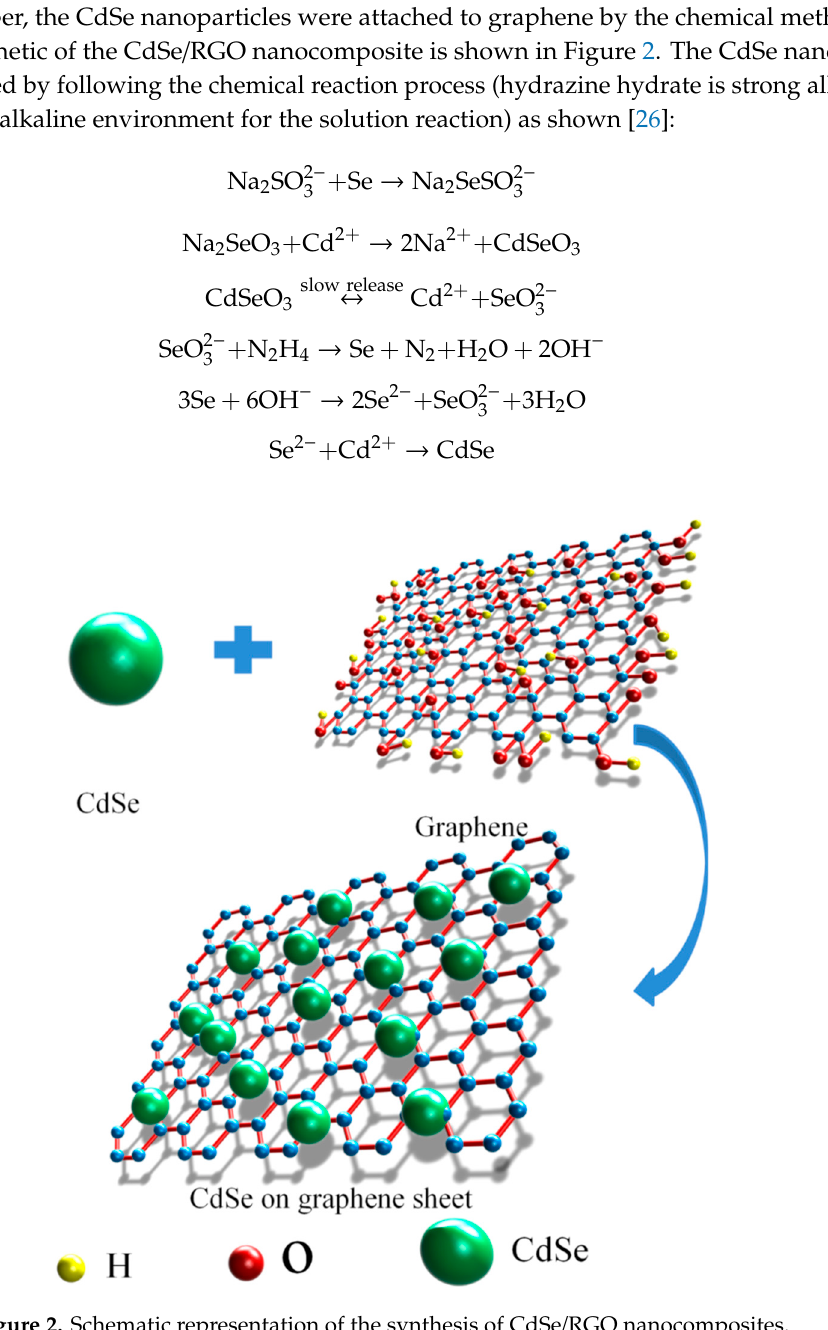
Figure 2. Schematic representation of the synthesis of CdSe/RGO nanocomposites.